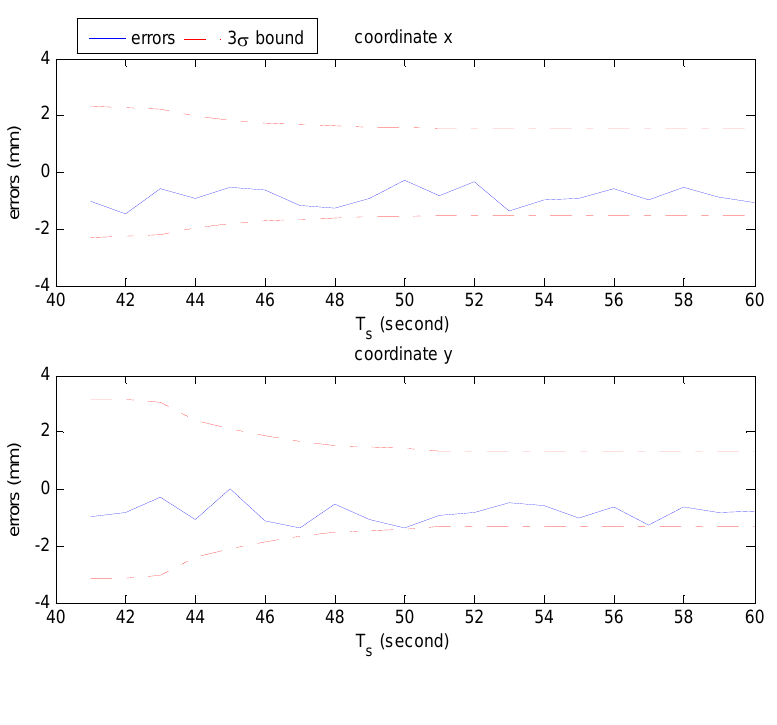
Figure 9. Errors between the actual and estimated location of endpoint 2 from 40th to 60th sample time. The 99% confidence limit is shown in red dash-dot